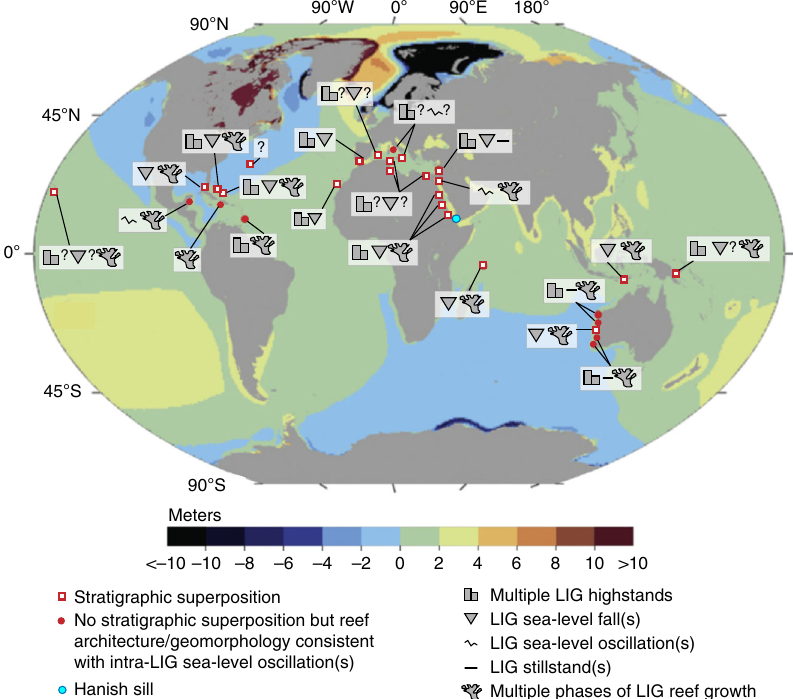
Fig. 1 Global summary of stratigraphic evidence for Last Interglacial sea-level instability in coral-reef deposits and coastal-sediment sequences. Blue dot is the location of Hanish Sill, the constraining point for the Red Sea sea-level record. Red squares with white centres are stratigraphically superimposed coral reef or sedimentary archives for sea-level oscillations within the Last Interglacial (LIG). Solid red dots are locations where sea-level oscillations are inferred but where there is no stratigraphic superposition. The underlying map is of the difference between maximum Last Interglacial (LIG) relative sea level (RSL) values for glacio-isostatic adjustment (GIA) modelling results based on two contrasting ice models (ICE-1 and ICE-3) for the penultimate glaciation using Earth model E1 (VM1-like set up). The ICE-1 model is a version of the ICE-5G ice history (LGM-like), whereas ICE-3 has both reduced total ice volume relative to ICE-1, and a different ice-mass distribution (i.e., a smaller North American Ice Sheet complex and larger Eurasian Ice Sheet) that is consistent with glaciological reconstructions of the penultimate glacial period